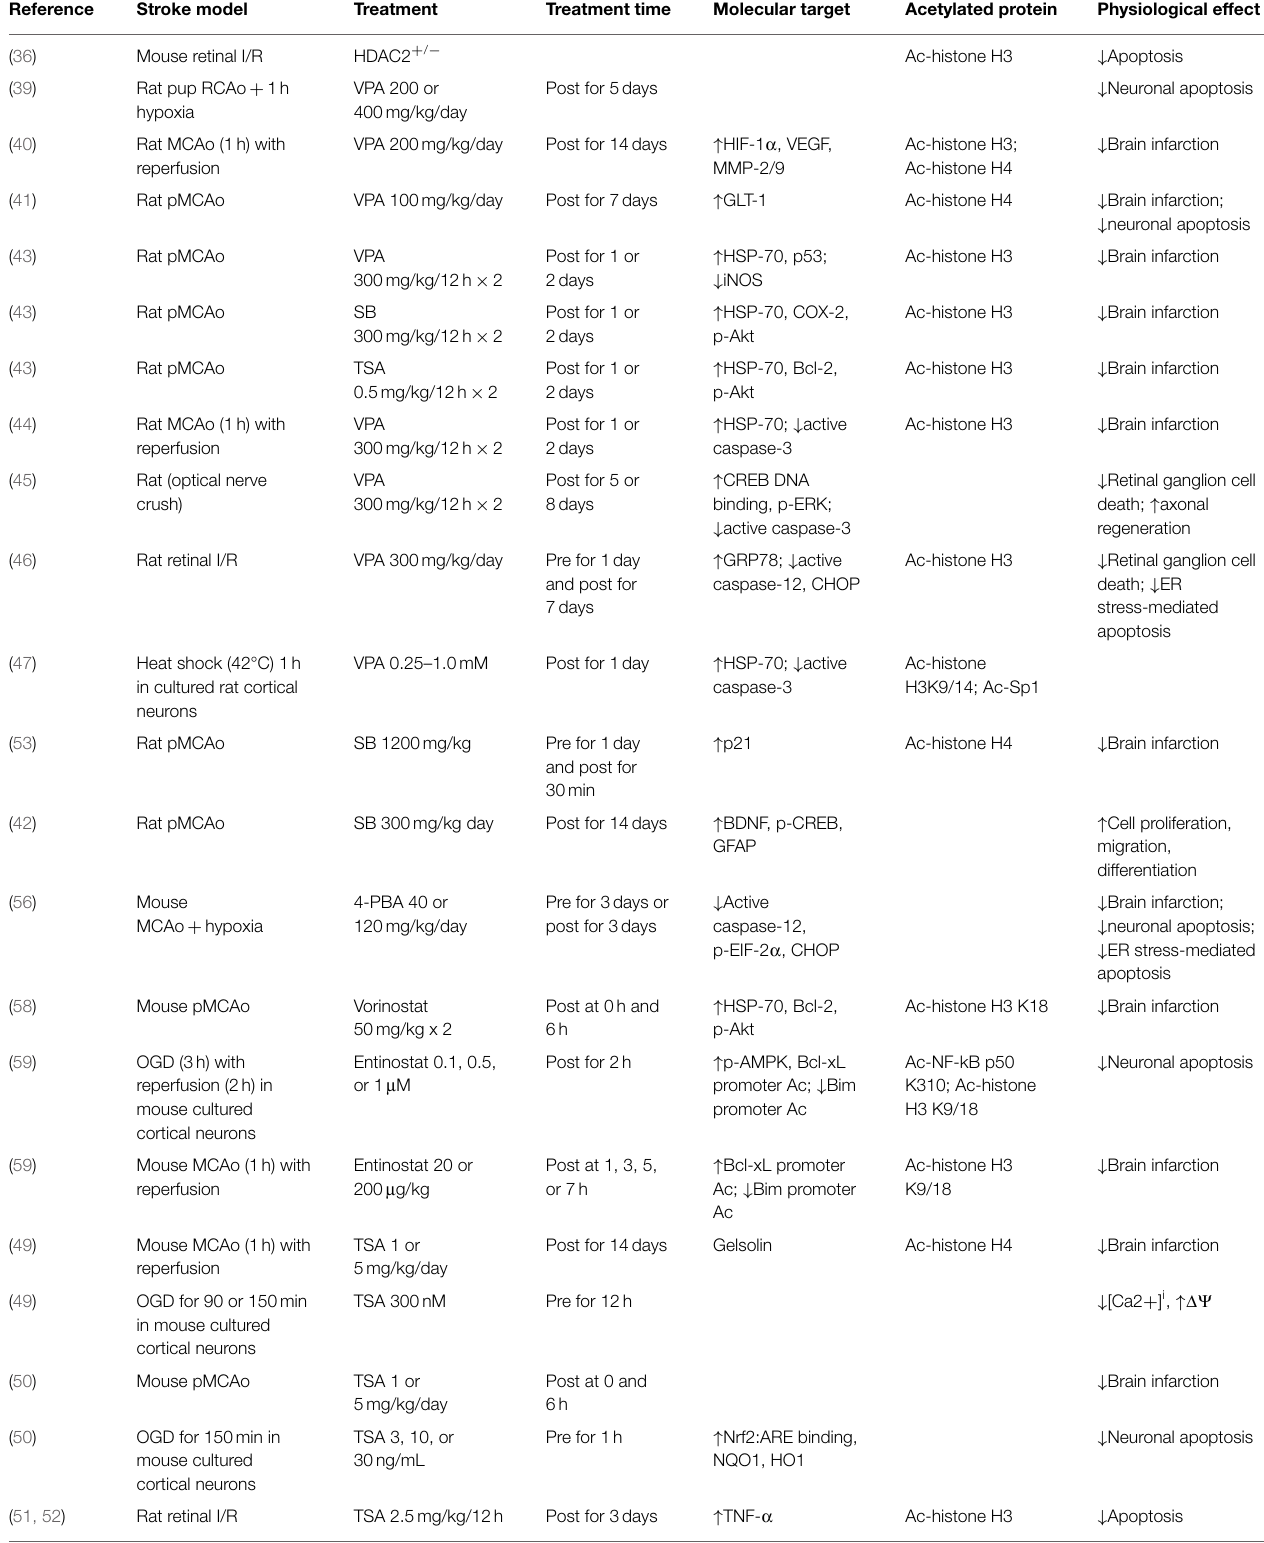
TABLE 1 | Physiological effects of HDAC inhibitors in experimental models of stroke